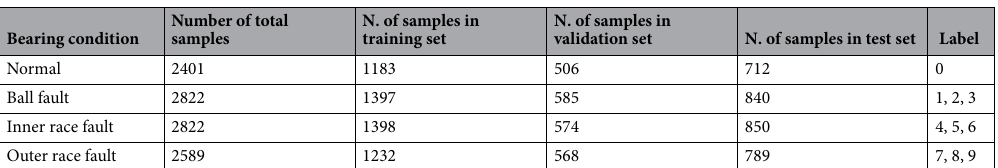
Table 2. CWRU bearing data